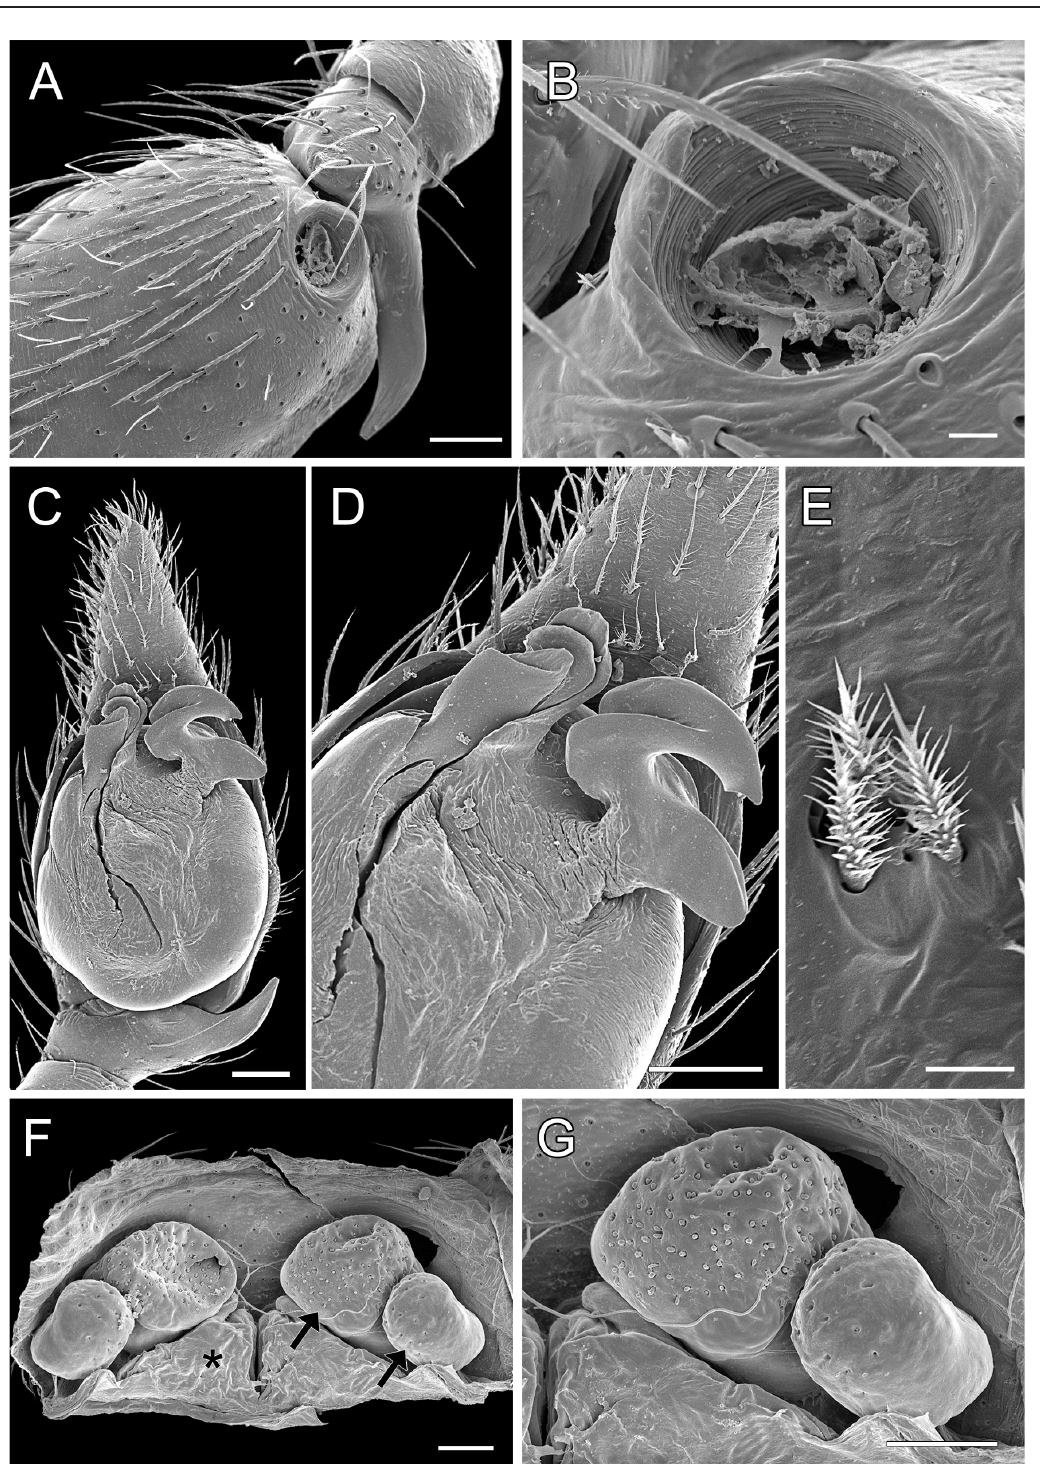
Fig. 9. Acanthinozodium sahelense sp. nov. SEM photos of ♂ and ♀ from Faro Game Reserve (MRAC 221183). A . Male palp, base of cymbium, dorsal view. B . Detail of previous showing “plug pit”, dorsal view. C . Male palp, ventral view. D . Detail of previous, showing MA in expanded position. E . Male, femoral organ. F . Epigyne, after digestion, dorsal view; arrows indicate the two spermatheca chambers; star indicates the atria. G . Detail of previous showing spermatheca with two chambers. Scale bars: A, C–D, F–G = 100 μm; B, E = 10